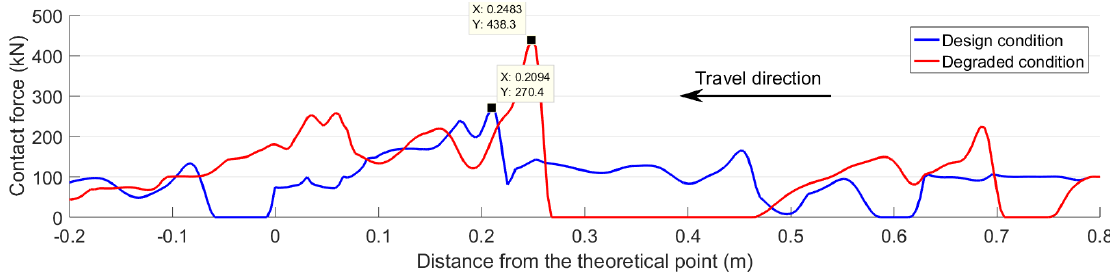
Figure 27. Wheel − rail contact forces in different rail conditions.